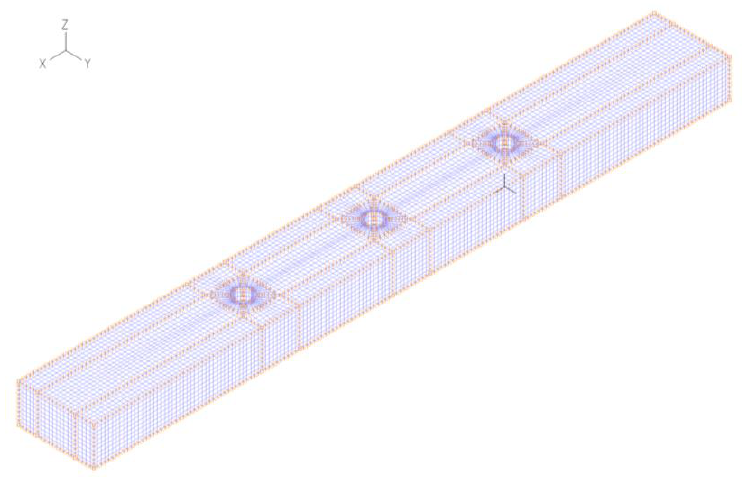
Figure 5. Laminar flow field meshing diagram.